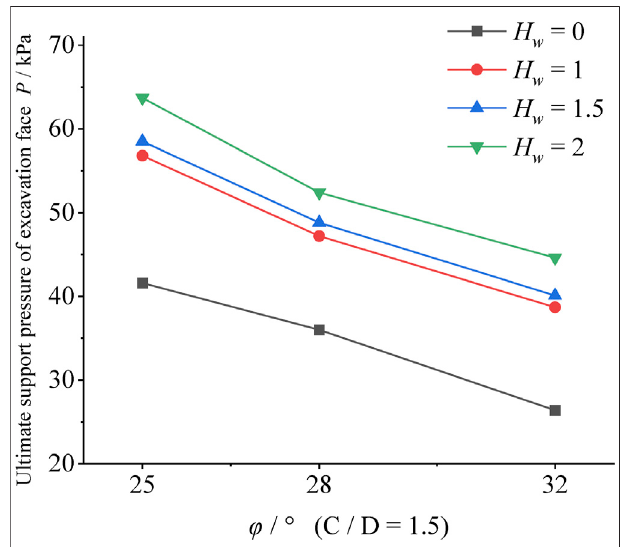
FIGURE 6 | Relationship between limit support pressure and ratio of tunnel C / D .